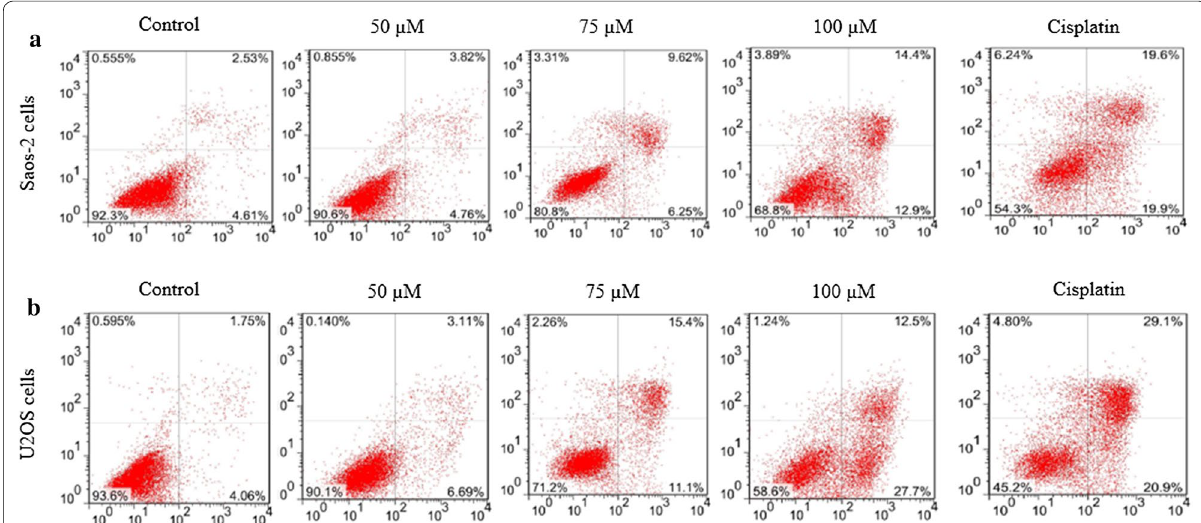
Fig. 3 Mangiferin effect on the osteosarcoma cell apoptosis. Cells were incubated with mangiferin (50–100 µM) for 72 h. a : represents the Annexin-VFITC of Saos-2 cells, b : represents the Annexin-VFITC of U2OS cells. N